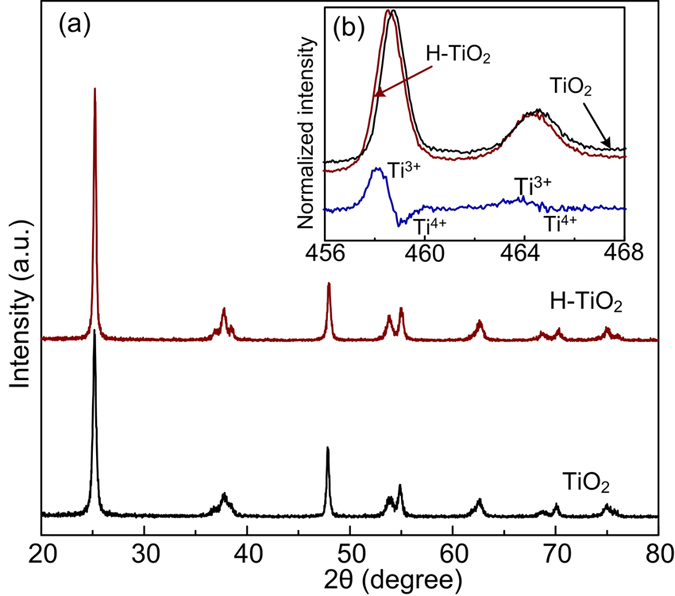
(a) XRD patterns and (b) normalized Ti 2p XPS spectra of anatase TiO2 and hydrogen reduced TiO2.